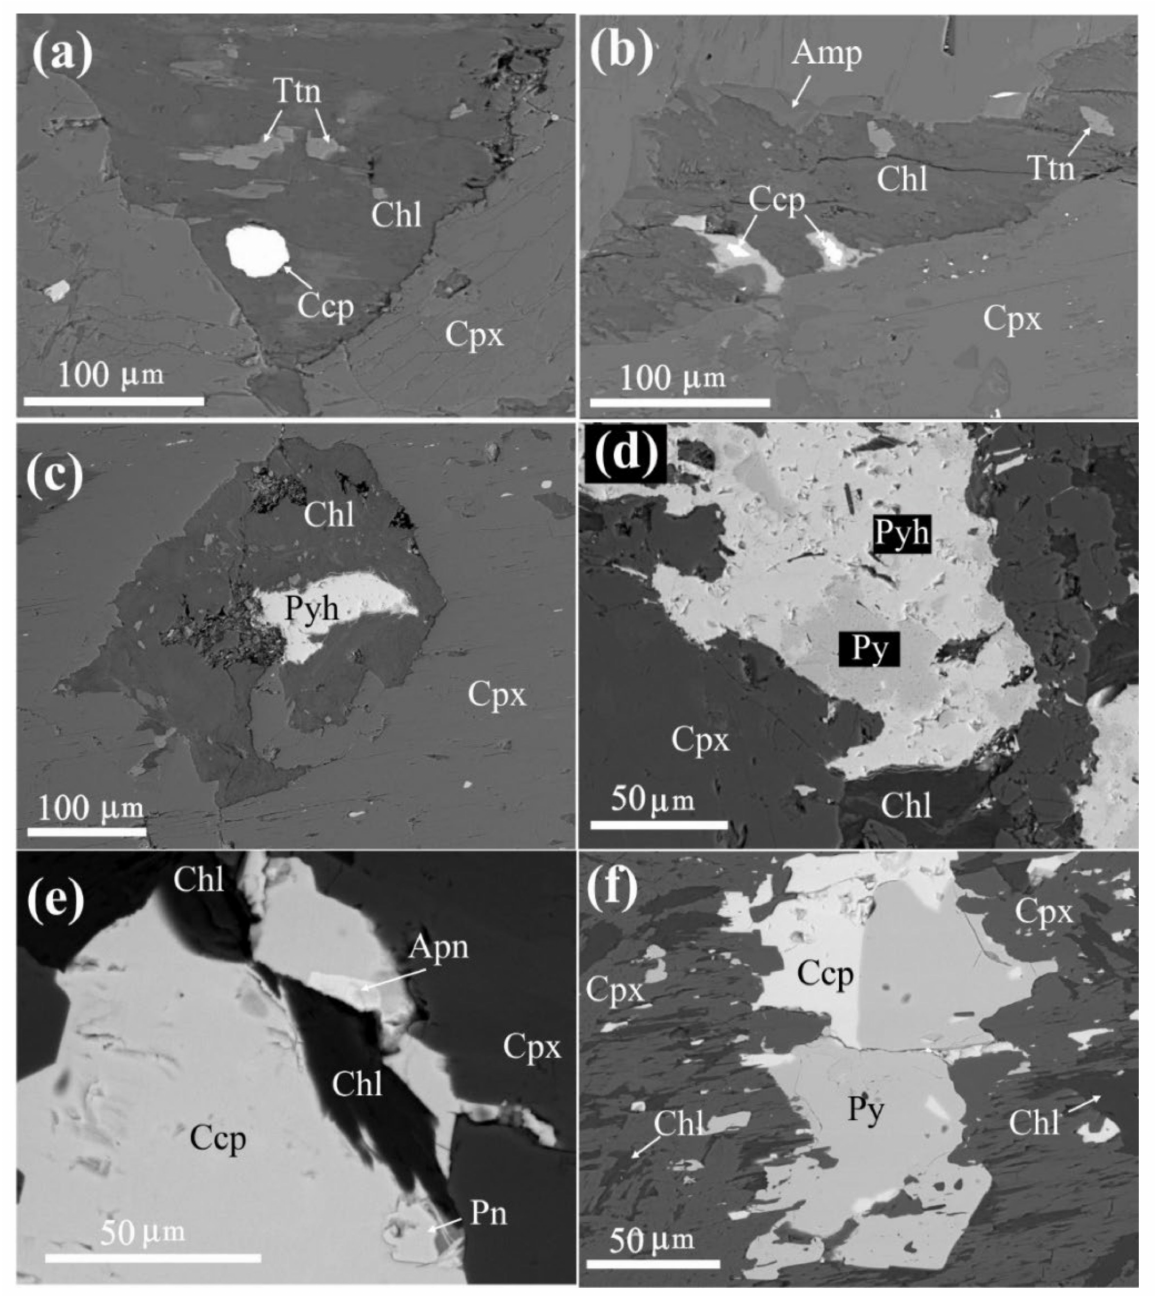
Figure 9. Relationships of sulfide minerals in clinopyroxenites I ( a – d ) and III ( e , f ). ( a ) Intersti- tial chlorite (Chl) with inclusions of chalcopyrite (Ccp) and titanite (Ttn) in clinopyroxene (Cpx); ( b ) chlorite veinlets with amphibole rim (Amp) in clinopyroxene. Chlorite contains grains of titanite (Ttn) and partially oxidized chalcopyrite; ( c ) interstitial chlorite with inclusions of pyrrhotite (Pyh) in clinopyroxene; ( d ) intergrowth of pyrite (Py), pyrrhotite, and chlorite in clinopyroxene; ( e ) segre- gation of chalcopyrite in intergrowth with argentopentlandite (Apn), pentlandite (Pn), and chlorite in clinopyroxene; ( f ) interstitial segregations of pyrite and chalcopyrite in clinopyroxene. Chlorite develops along the cleavage